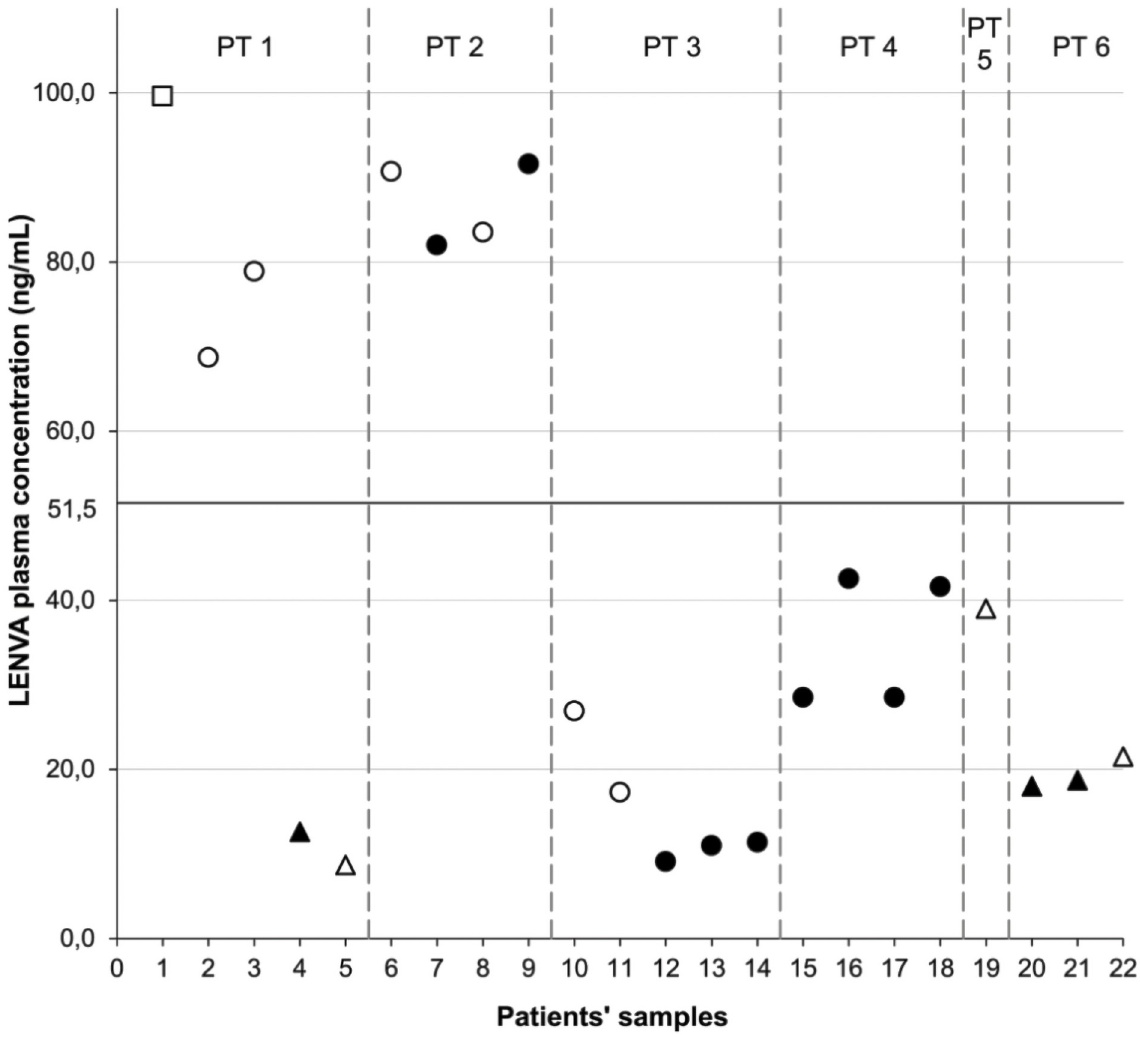
Fig 4. Graphical representation of LENVA concentrations in patients’ plasma samples. ( □ ) corresponds to sample at the dose of 12 mg/day of LENVA collected not at the C min ; ( ● ) 8 mg/day at the C min and ( � ) not at the C min ; ( ▲ ) 4 mg/day at the C min and ( Δ ) not at the C min . The line at 51.5 ng/mL corresponds to the mean C min reported in the literature as proposed TDM